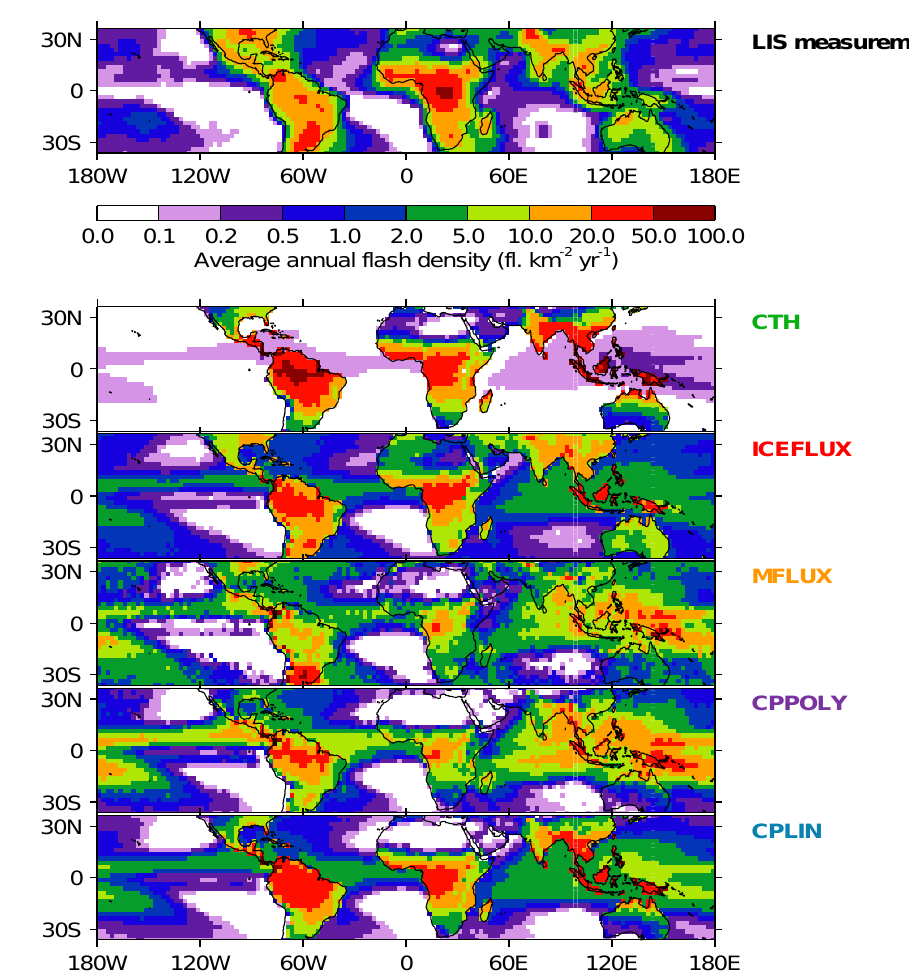
Figure 6. Five-year climatological annual total flash density (2007–2011). Results are shown for the LIS measurements and the five